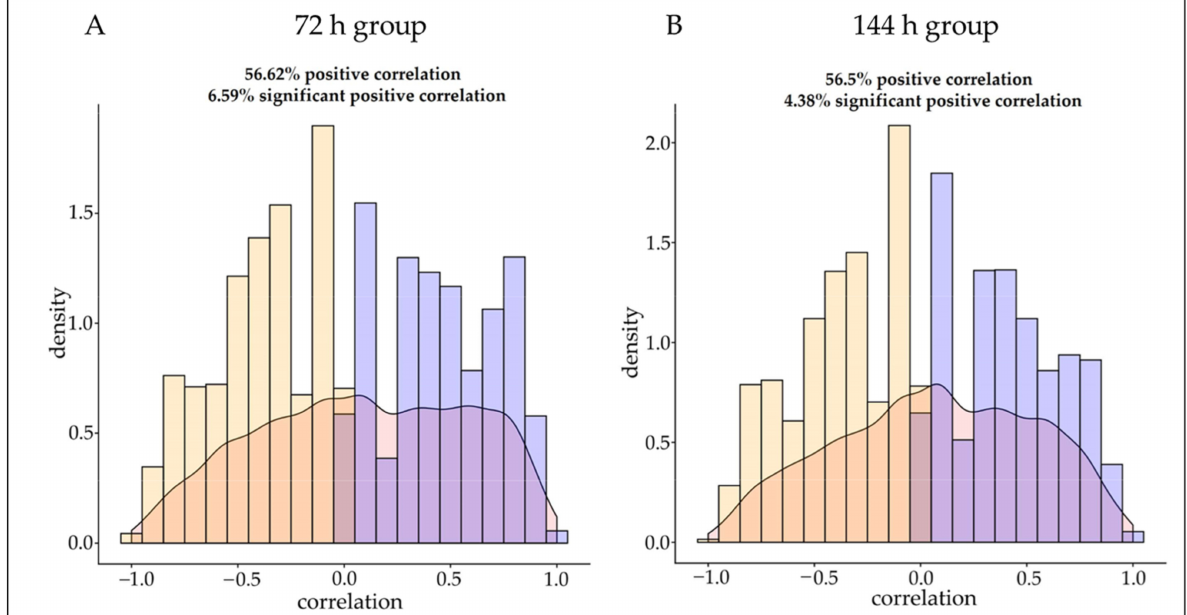
Figure 3. Correlation between protein and mRNA abundance in infected dairy goats. Density plot ( A ) showing the global Spearman correlation for protein–mRNA pairs with the 72 h infection group. Density plot ( B ) showing the global Spearman correlation for protein–mRNA pairs with the 144 h infection